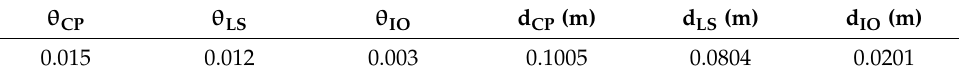
Table 5. Inter-story drifts and displacements for different limit states according to FEMA 356 prescriptions.